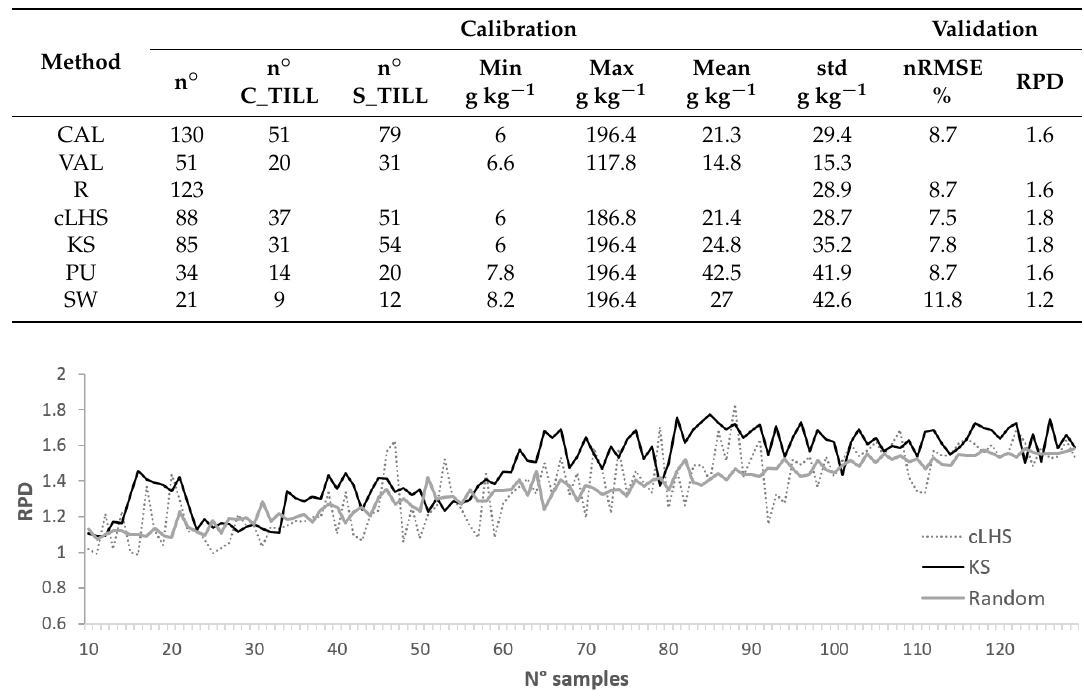
Table 3. Descriptive statistics of the SOC content of the calibration datasets detected by the sampling selection algorithms at regional scale and the estimation accuracy in terms of normalized root mean square error (nRMSE), ratio of the performance to deviation (RPD) from the validation dataset. The number of selected samples within each soil association region: clay till (C_TILL) and Sandy till (S_TILL) are given.